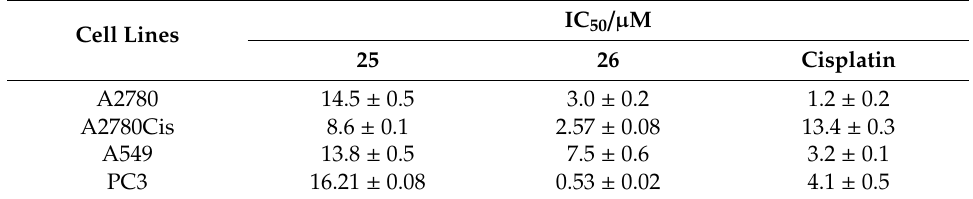
Table 1. IC 50 values for complexes 25 and 26 , and cisplatin against A2780 human ovarian, A2780Cis cisplatin-resistant human ovarian, A549 human lung, and PC3 human prostate cancer cell lines.